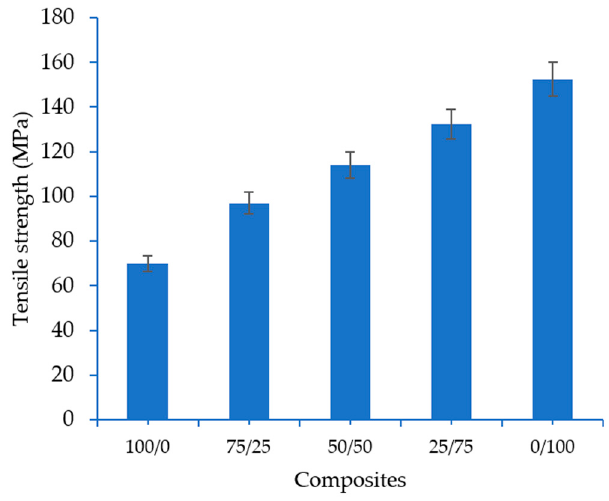
Figure 3. Tensile strength test results.